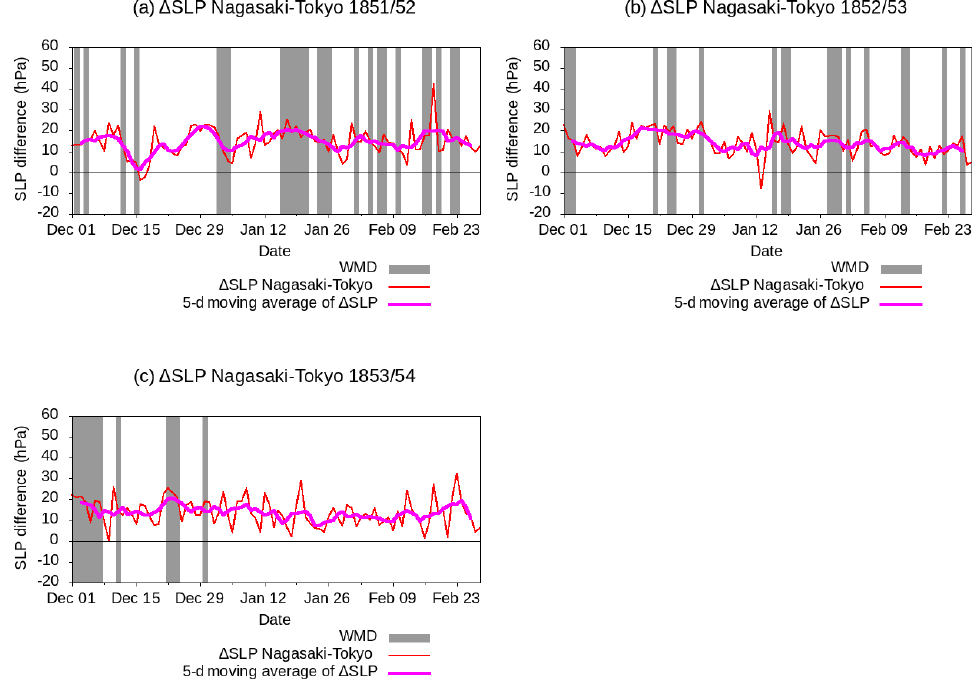
Figure 14. Temporal variations in surface pressure differences between Nagasaki and Tokyo ( (cid:49) SLP N–T) and winter monsoon outbreak dates (WMDs) for (a) 1851/52, (b) 1852/53, and (c) 1853/54.